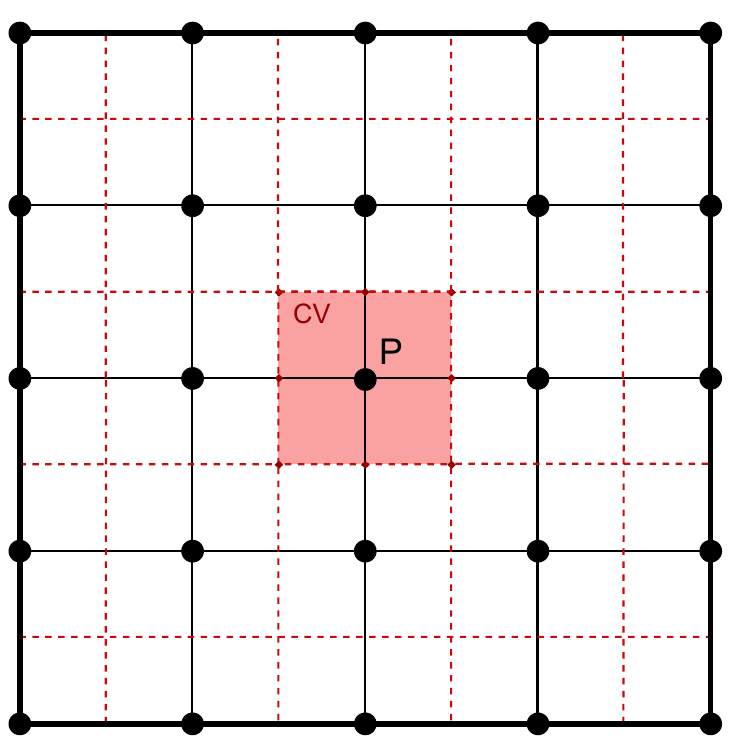
Figure 1. Illustration of both the primal grid (black continuous line) and dual grid (red dashed